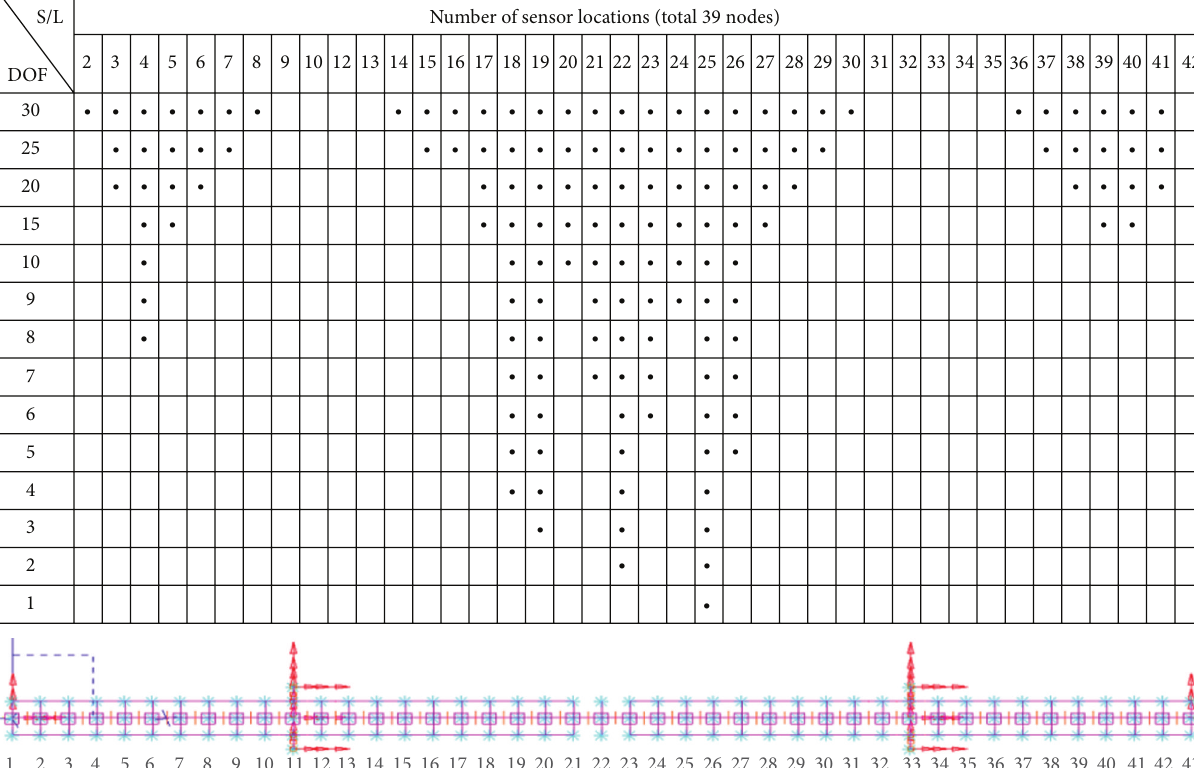
Figure 6: Study of optimal sensor locations selected using the EOT